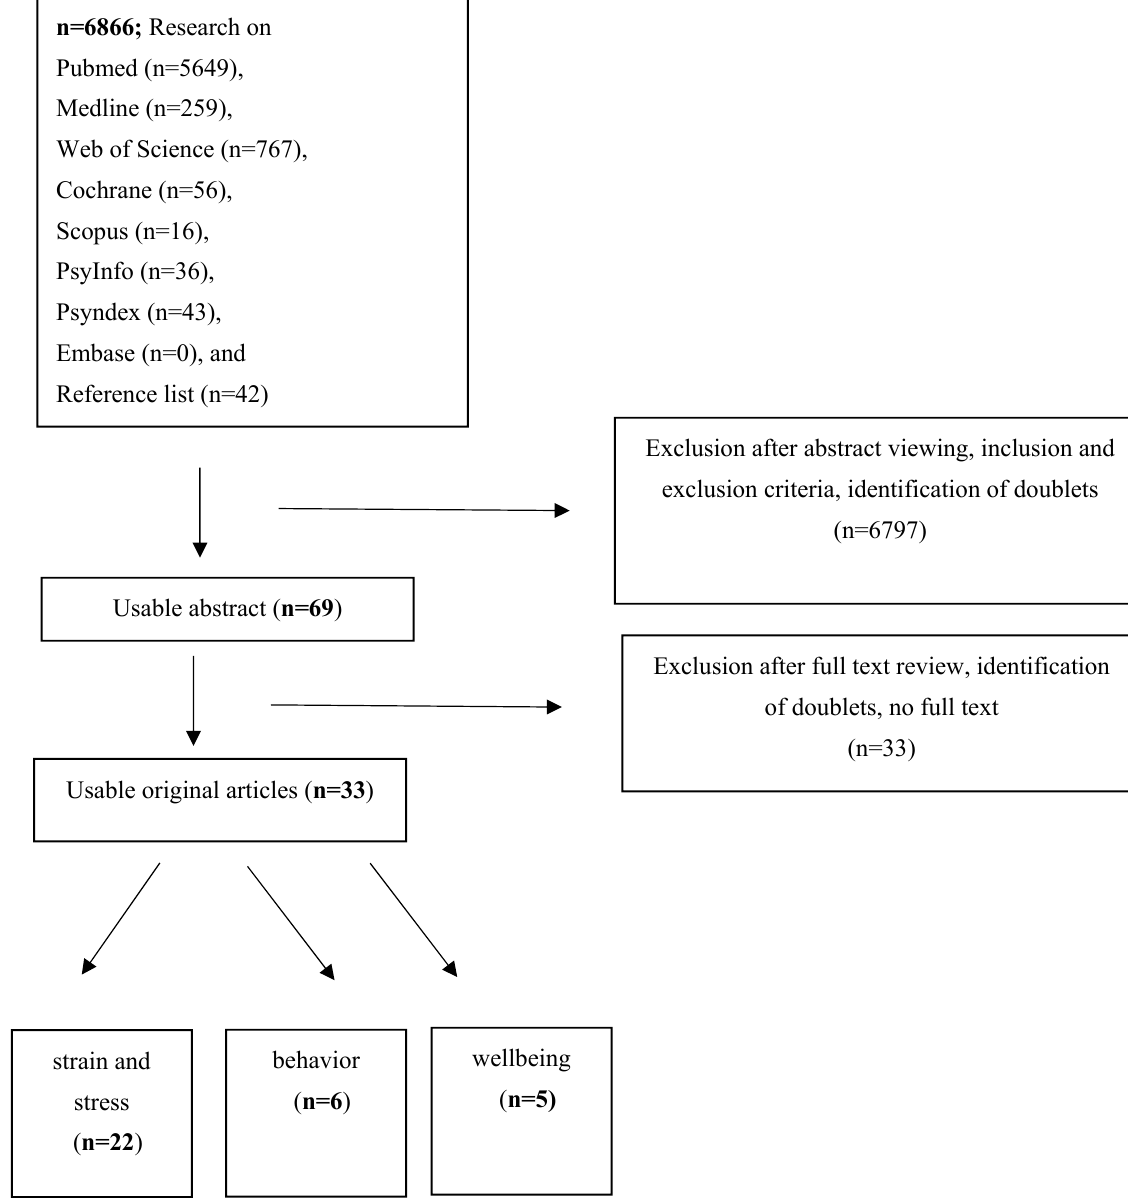
Figure 1. Flow chart of the review. Note. Some studies were assigned to two categories.